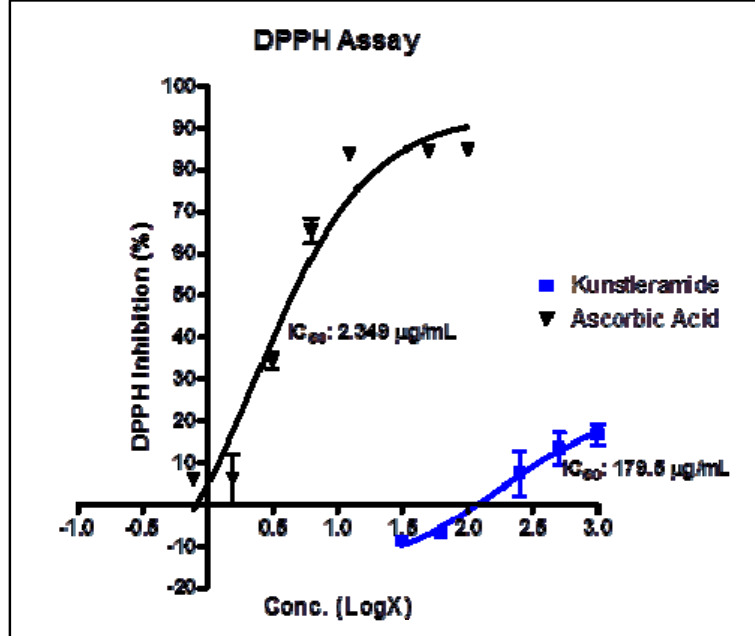
Figure 4. IC values of ( − )-kunstleramide ( 1 ). AA: ascorbic acid as control. Results are 50 means ± SD of two